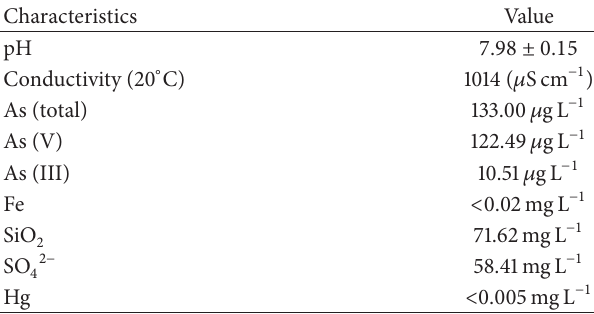
Table 1: Composition of the experimental